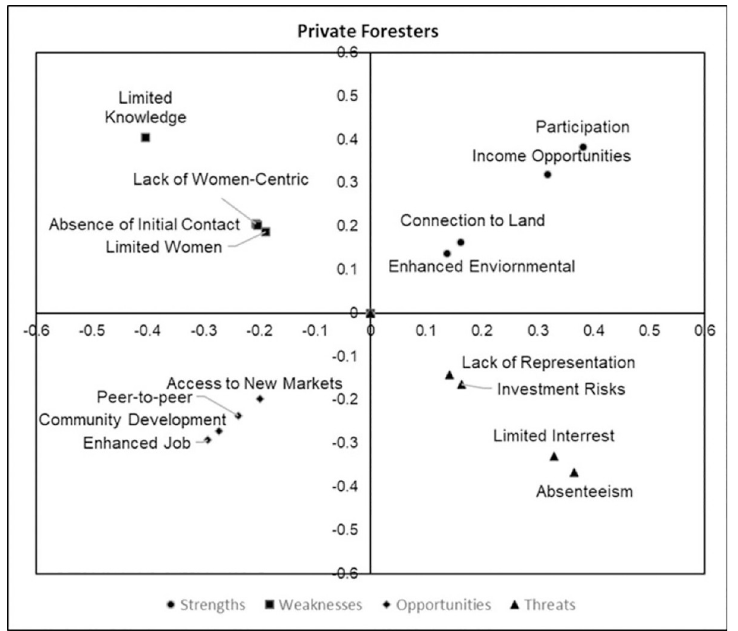
Fig 5. Perception map of factor priorities assigned by private